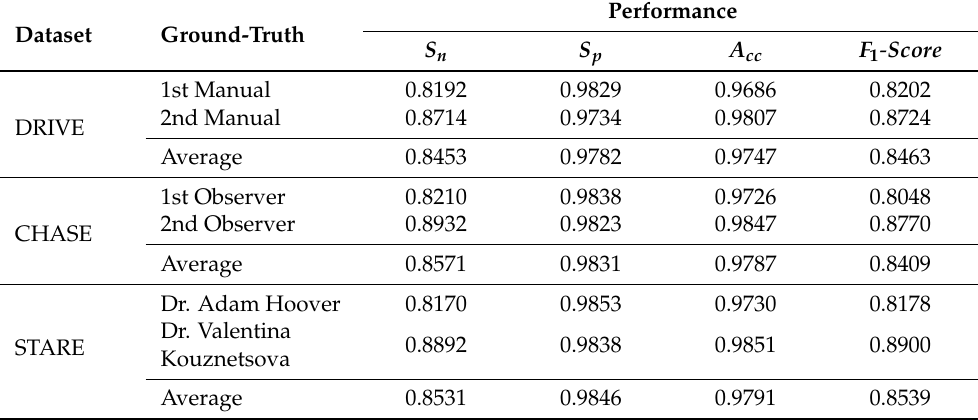
Table 1. Quantitative performance of the proposed G-Net light on DRIVE, CHASE and STARE dataset. Dataset